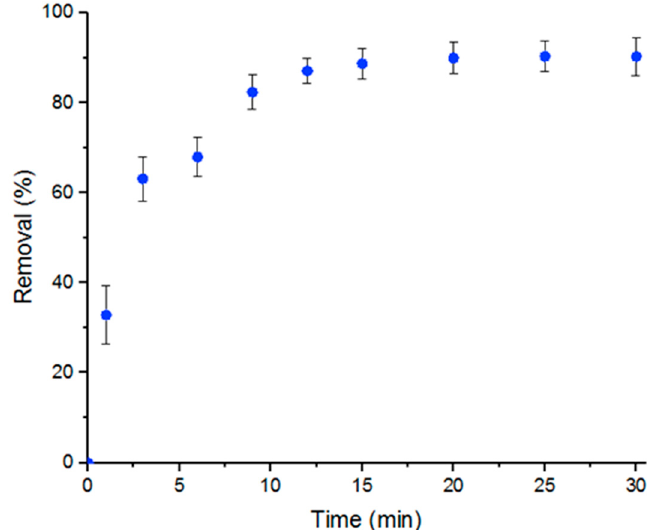
Figure 1. Percent removal of Doxycycline by UiO-66 within 30 min. Error bars represent the standard deviation of three independent adsorption experiments.